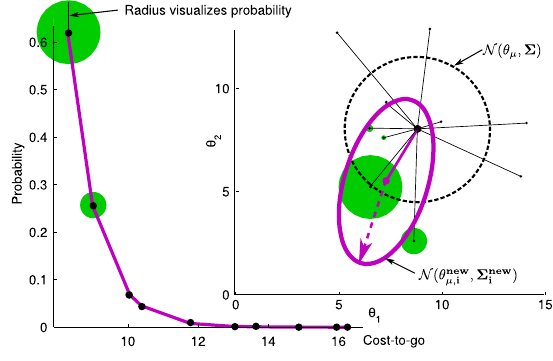
Figure 1. Visualization of a parameter update at one time step i . The upper rightgraphshowsthe2Dparameterspace, withthecurrentGaussian distribution(dashedblack), and K = 10 randomsamplestakenfrom it. The lower left graph shows the mapping from cost to probability. In this illustratory example, the minimum θ ∗ lies at [0,0]; samples θ k closerto[0,0]thushavelowercosts,andthereforehigherprobabilities (represented by green circles). The new distribution θ new µ,i , Σ new i for time step i (purple ellipse) is acquired through probability-weighted